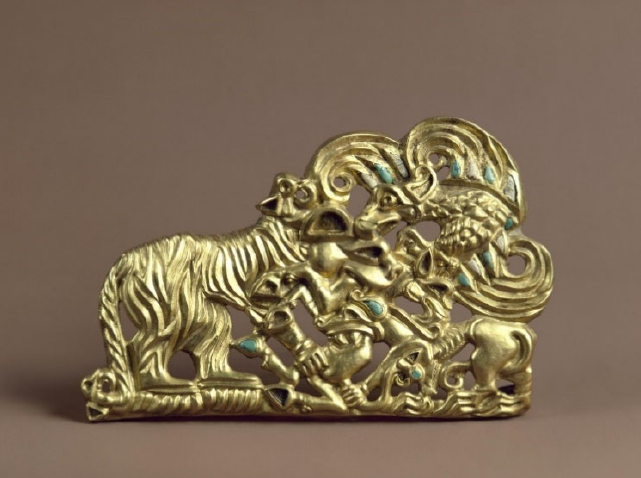
Figure 1. Belt plaque (right) with scenes of animal combat (SHM inv. no. C и .1727 ‐ 1/2); gold and turquoise; Siberian Collection of Peter I; c. 6th century BC. [Image is used